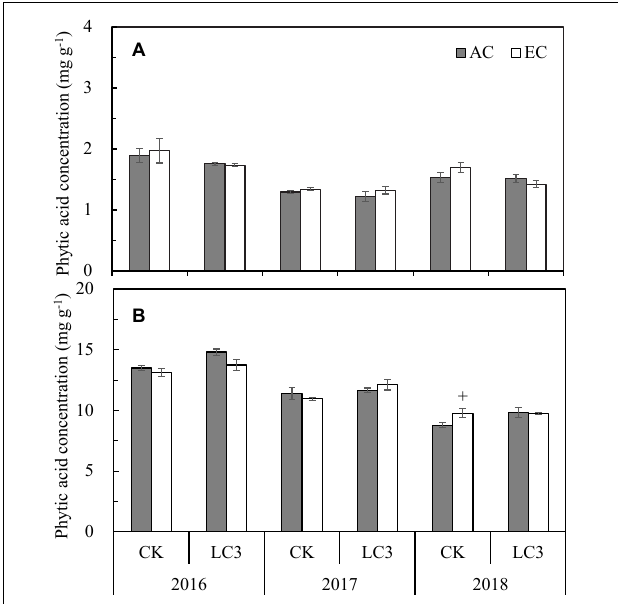
FIGURE 5 | The phytic acid concentration in milled rice (A) and brown rice (B) of WYJ27 as affected by elevated CO 2 under CK (no leaf cutting) and LC (cutting off top three leaves) across three cropping seasons (2016-2018). Each bar in the figure represents the mean values across three plots for ambient CO 2 (AC, filled square) or elevated CO 2 (EC, AC + 200 ppm, unfilled square); vertical bars represent standard error ( n = 3). Statistically significant effects are indicated as + P <